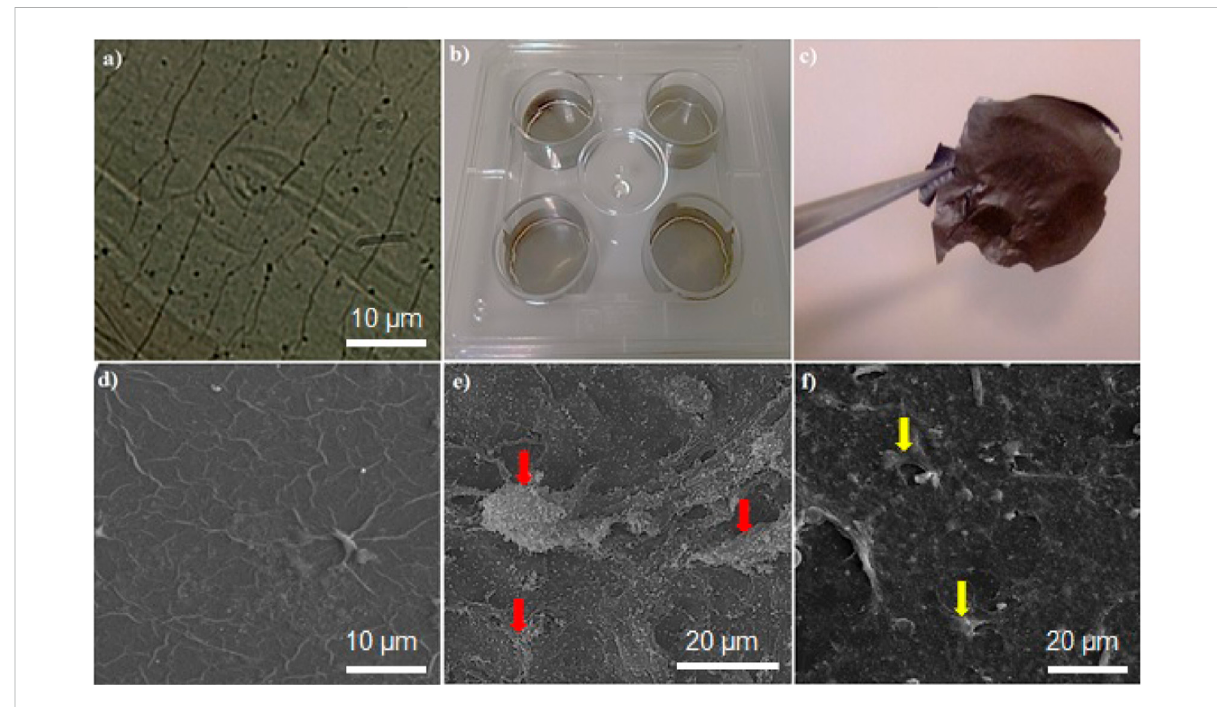
FIGURE 5 (A) Microscopic image of the graphene-based platform, (B) plate coated by graphene platform, (C) graphene fi lm; SEM images of (D) the graphene-basedplatform, (E) hMSCsattachedongrapheneplatform, (F) differentiatedcellsonthegraphene-basedplatform.Redandyellowarrows show hMSCs and differentiated cells,